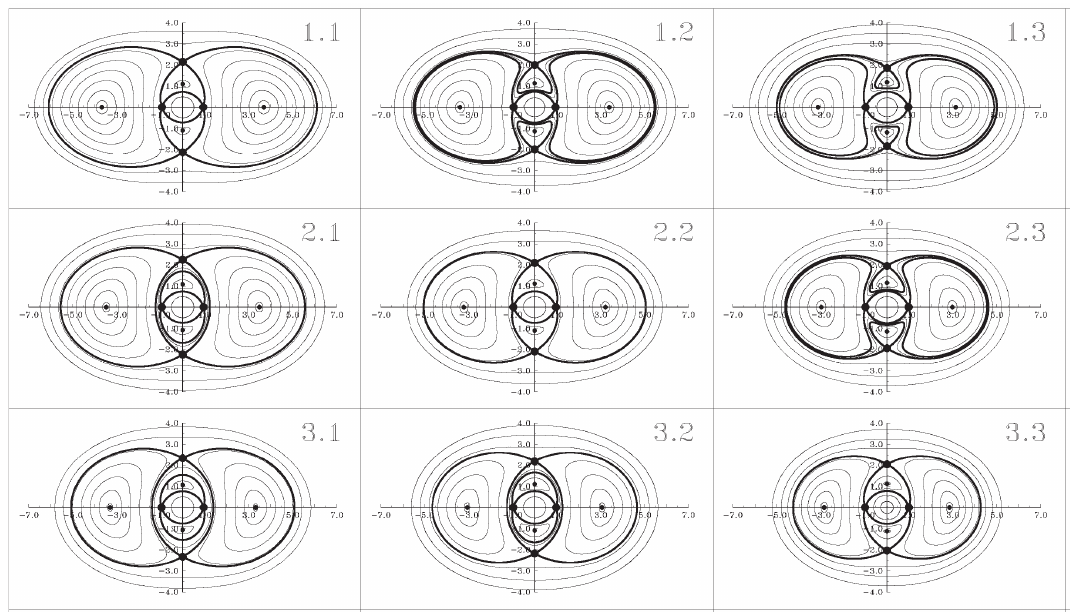
Figure 5. Stationary phase portraits for any vortex in the bottom layer for various combinations of parameters S 0 and Ω 0 , respectively: rows, 0.1574, 0.1724, and 0.1874; and columns, 0.0569, 0.0469, and 0.0374. The diagonal panels (1.1, 2.2, and 3.3) represent the process of reconnection.